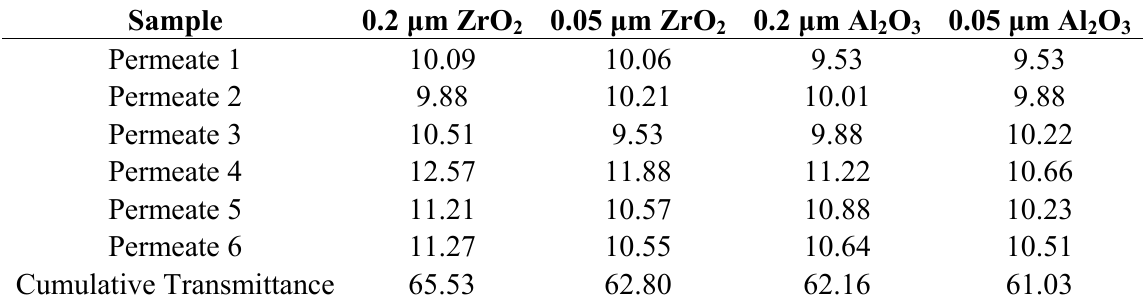
Table 1. Dynamic transmittance of ferulic acid in